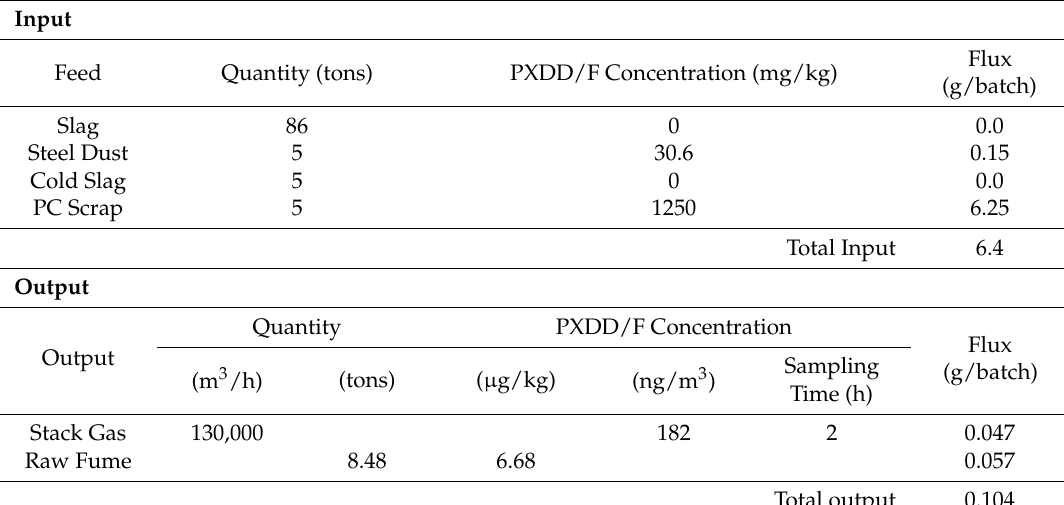
Figure 17. Monthly average coal consumption rate [96]. Mechanisms of e-waste recycling involves combination of recovery methods such as mechanical recycling, feedstock recycling, thermal depolymerization and energy recovery. Plastic components of e-waste cannot be easily recycled due to the mix of flame retardants, pigments and mixed types of plastics. The most common outlets for these mixed fractions are landfill and incineration plants, which are becoming increasingly restricted and costly given recent legislative developments. Where re-use of plastic components from the e-wastes is not possible, mechanical recycling is opted. In mechanical shredding and sorting processes for e-scrap (pre-treatment), large volumes of various mixed plastic fractions are usually generated. Often, it is not economically viable to separate these further and recover the various types of plastic. There is also a difficulty of achieving acceptable product quality. Limited markets for recycled polymers and innovations in polymer performance and consumer acceptance add to the problems. This is because of the contamination during sorting process of plastics and subsequently during the recycling process affect the product quality adversely. Furthermore, all residual metals still contained in them would inevitably be lost. Separating residual metals by mechanical means can become quite costly while generating only little additional metal value. Mechanical recycling of older WEEE which contains plastics cause problems when dismantling processes do not utilize adequate means, facilities and trained people. Plastic content in the e-waste is used either as a chemical feedstock to replace the reducing agents, CO and H 2 , or as fuel [96] due to their high calorific values. Without strict temperature control during extrusion, there is a potential risk of generating dioxins and furans from some halogenated flame-retardants [96], which can be addressed as already discussed.